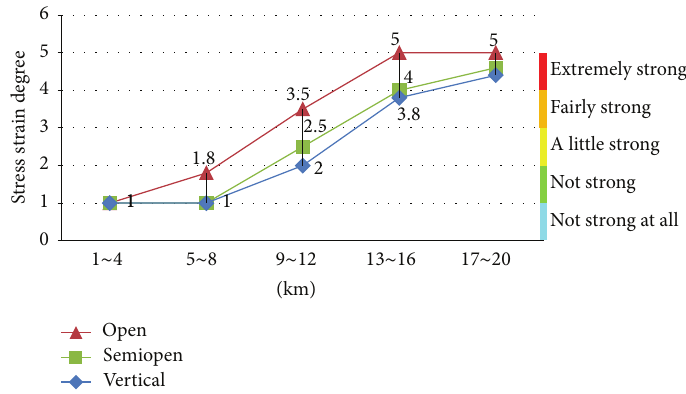
Figure 9: Stress variation trend with the trip length in each scenario. Table 9: Polynomial coefficients 𝑞 𝑖 and fitting degree 𝑅 2 of the curves in the field